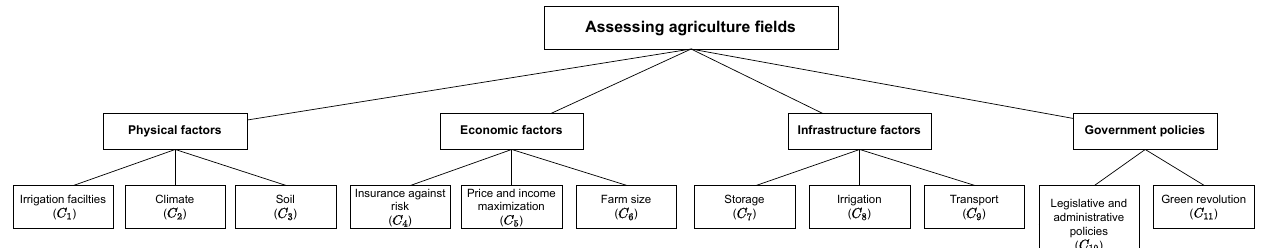
Figure 1. Framework of Evaluation